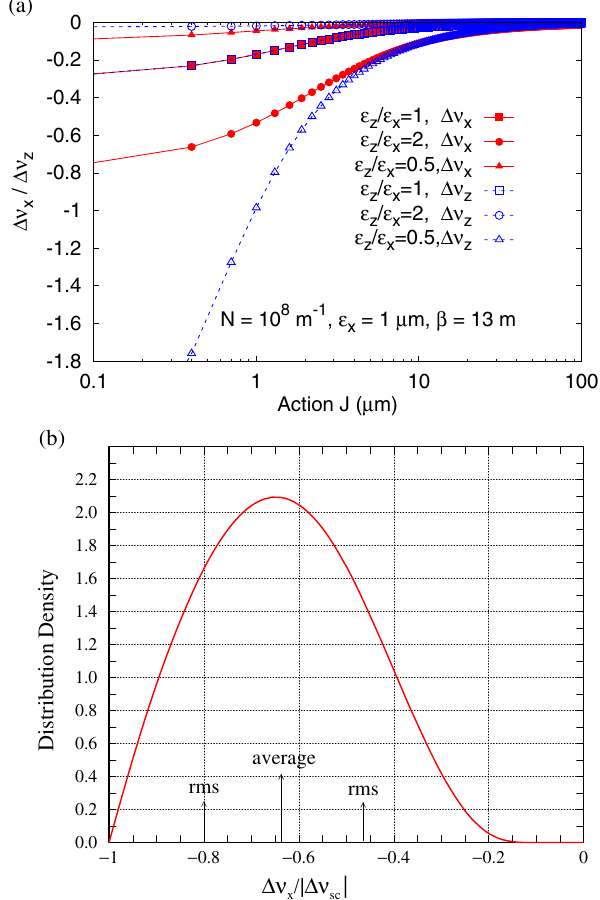
FIG. 1. (a) Tune shifts as a function of particle ’ s action. (b) Tune spread distribution scaled with the Laslett tune shift Δ ν for round beams with equal bare tunes (courtesy Ng sc